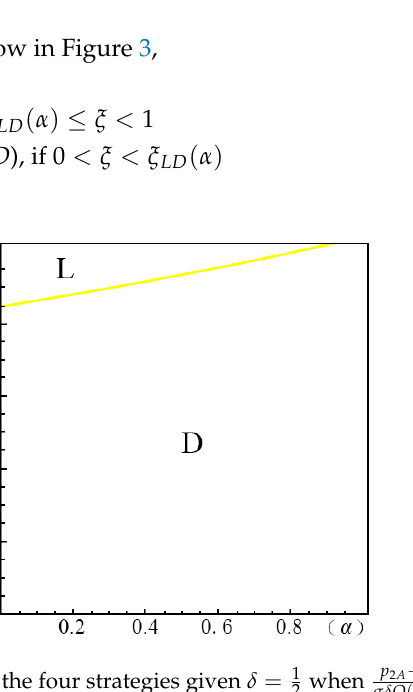
Figure 3. Comparison of the four strategies given (cid:2012) (cid:3404) (cid:2869)